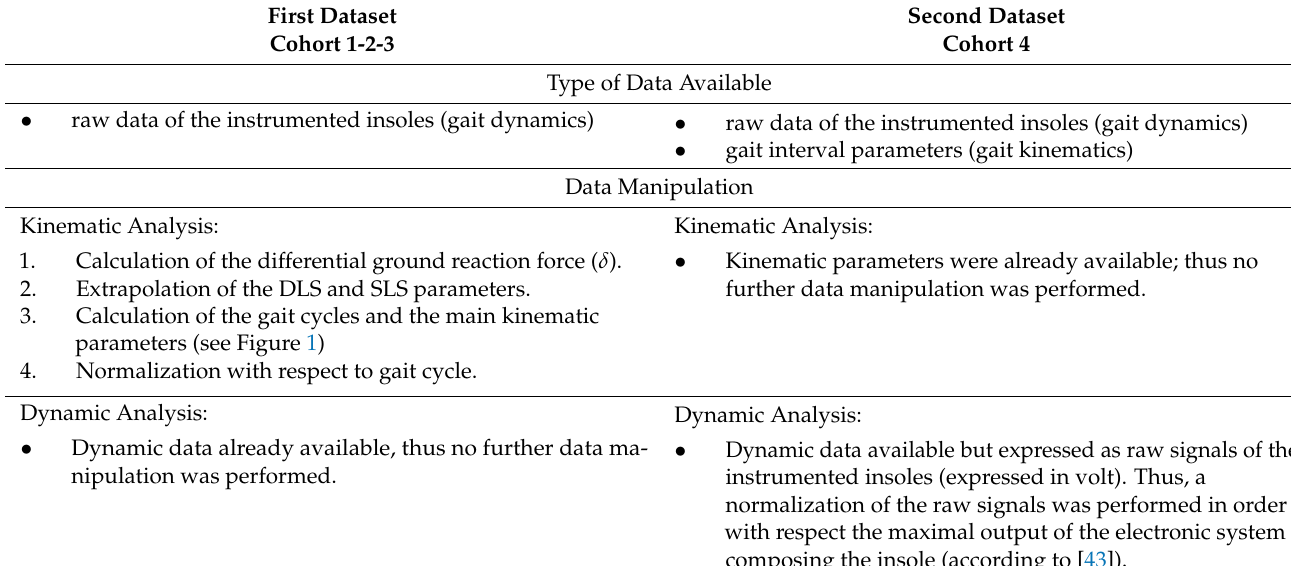
Table 2. Overview of the main data manipulation steps.